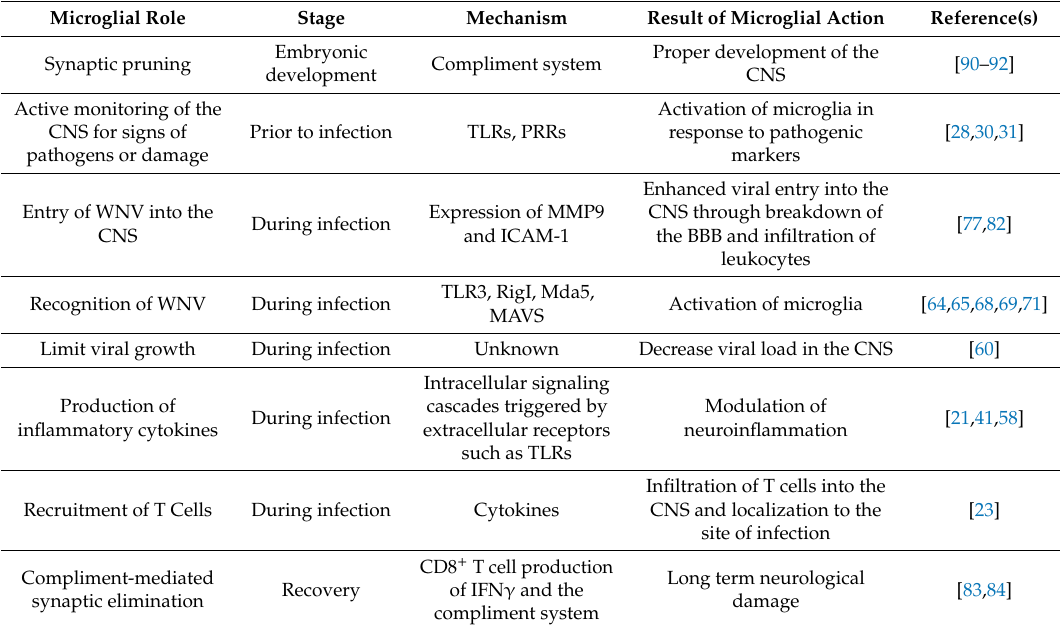
Table 1. Role of microglia in the CNS before, during, and after neuroinvasive WNV